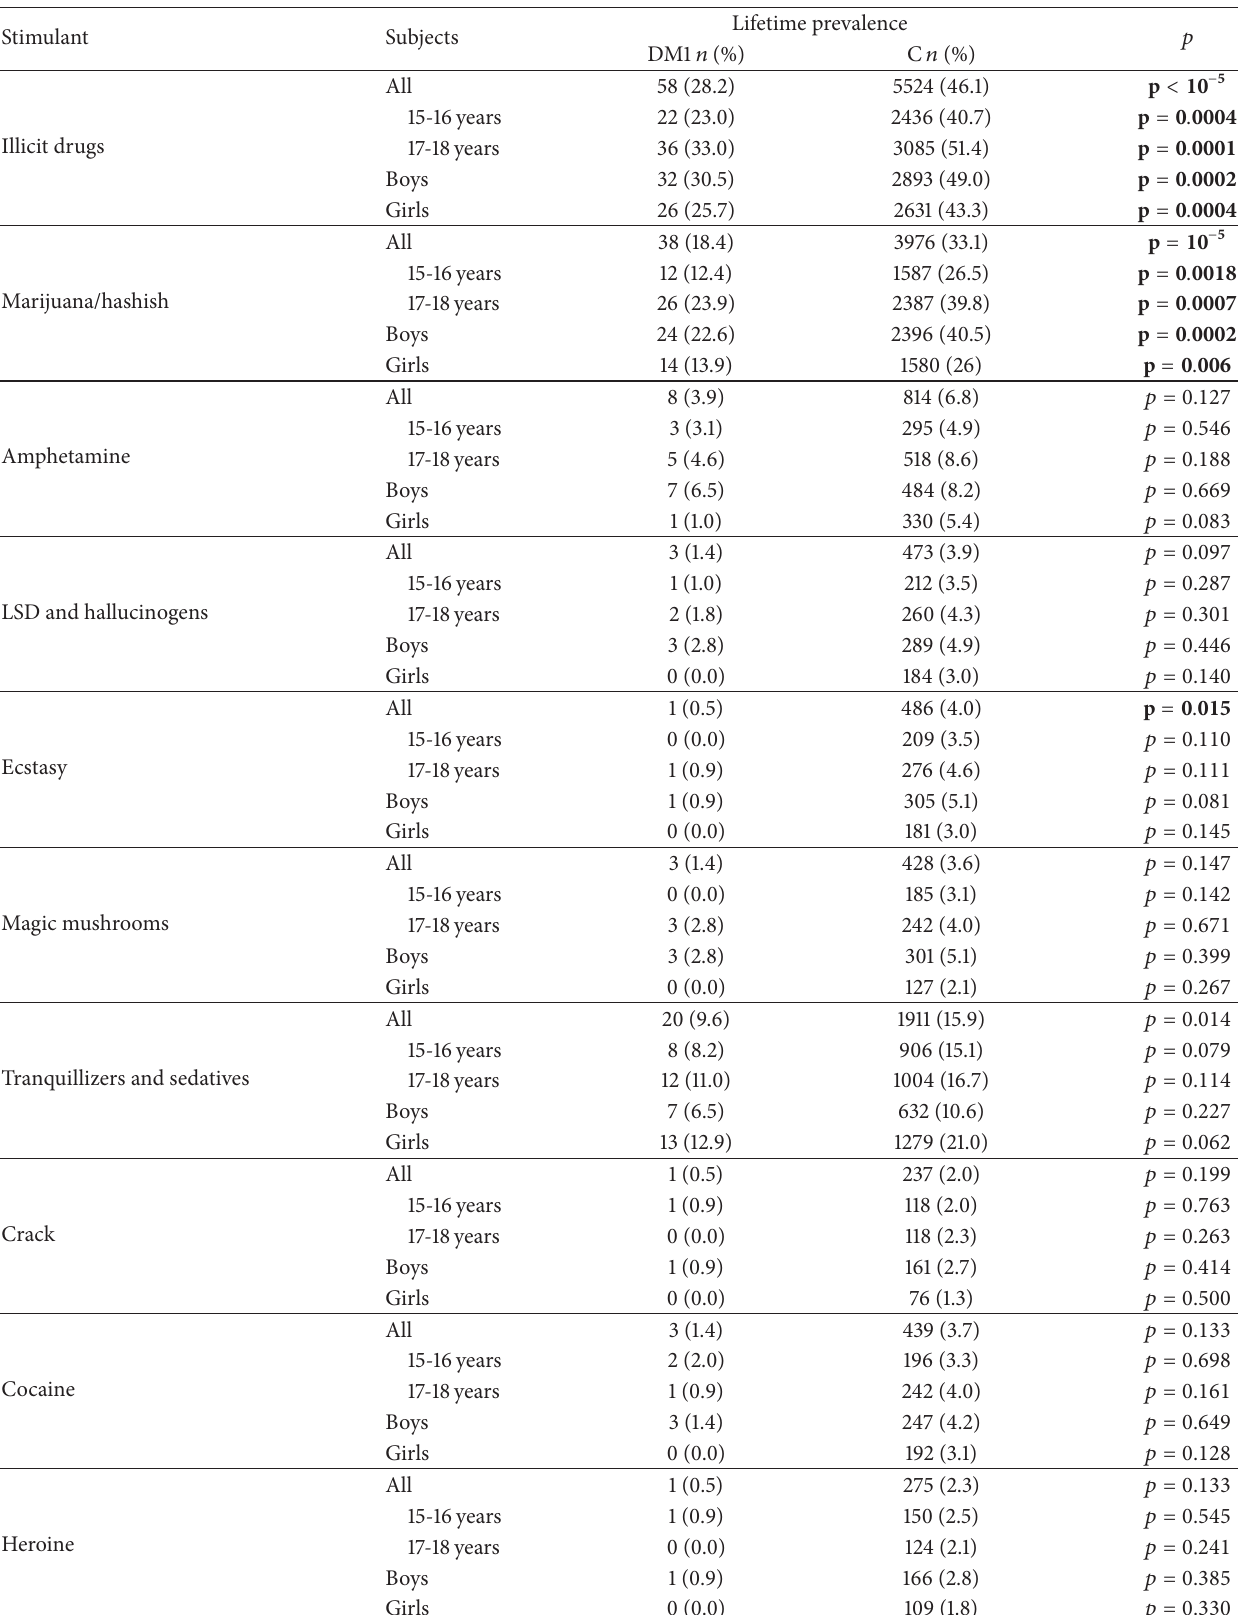
Table 2: Lifetime prevalence of illicit drugs use in 209 teenage patients with T1D compared with their healthy peers ( 𝑛 = 12114).